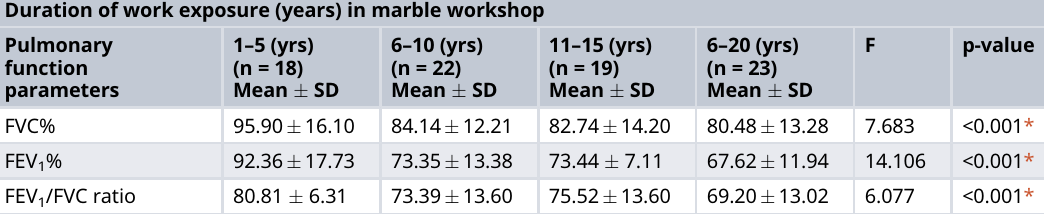
Table4.Resultsofpulmonaryfunctionparametersamongmarbleworkersbyyearsofworkexposure(n=82).